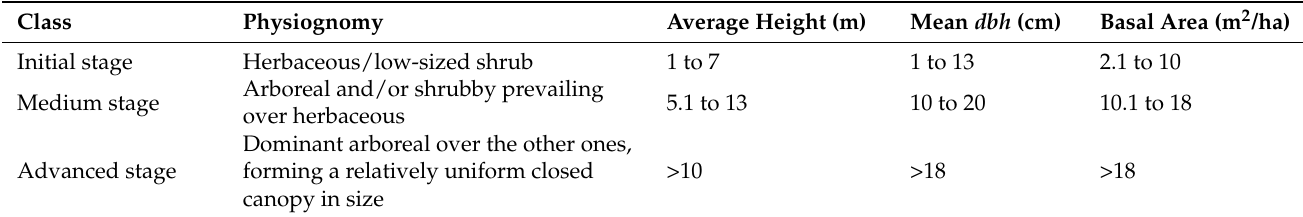
Table 2. Criteria for classification of succession stages of the studied